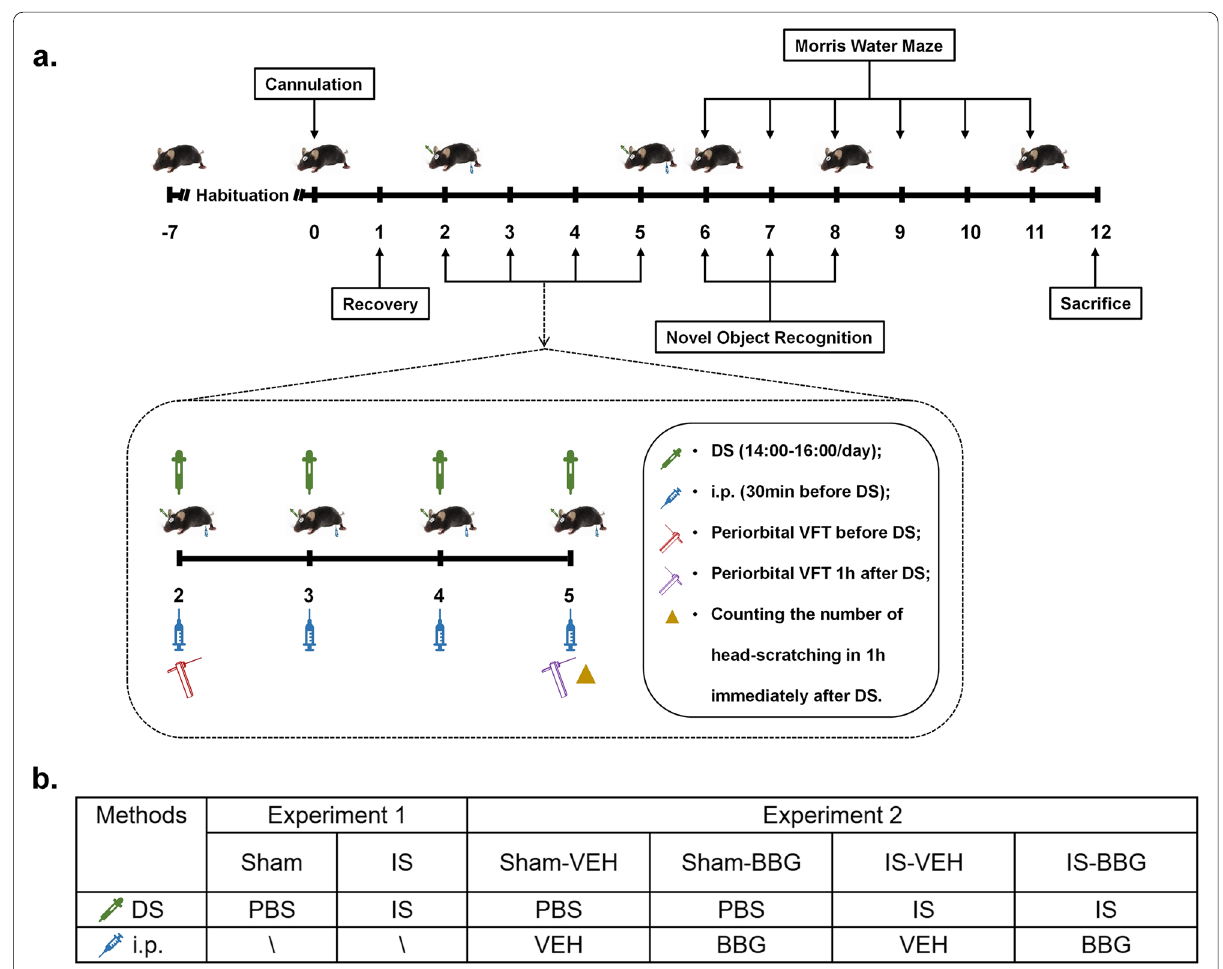
Fig. 1 The experimental protocol of the study. ( a ) Schematic timeline diagram of drug treatment and behavioral assessment in mice. ( b ) Details of the dosing regimen for each group of mice. IS, 20μL/day for 4 days, dural injection; PBS, 20μL/day for 4 days, dural injection; BBG, a specific P2X7R antagonist, 50 mg/kg/day for 4 days, intraperitoneal injection; VEH, 0.9% saline, the same volume as BBG, intraperitoneal injection. Abbreviations: DS, dural stimulation; i.p., intraperitoneal injection; VFT, von Frey’s test; IS, inflammatory soup; PBS, phosphate buffer saline; BBG, brilliant blue G;